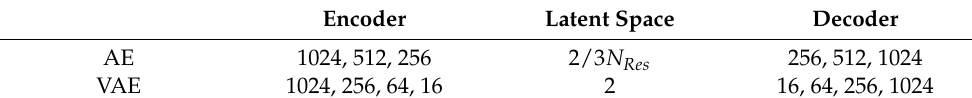
Table 1. Structure of AEs and VAEs where all encoders and decoders are deep neuron networks. Here N Res denotes the number of residues of the input protein.